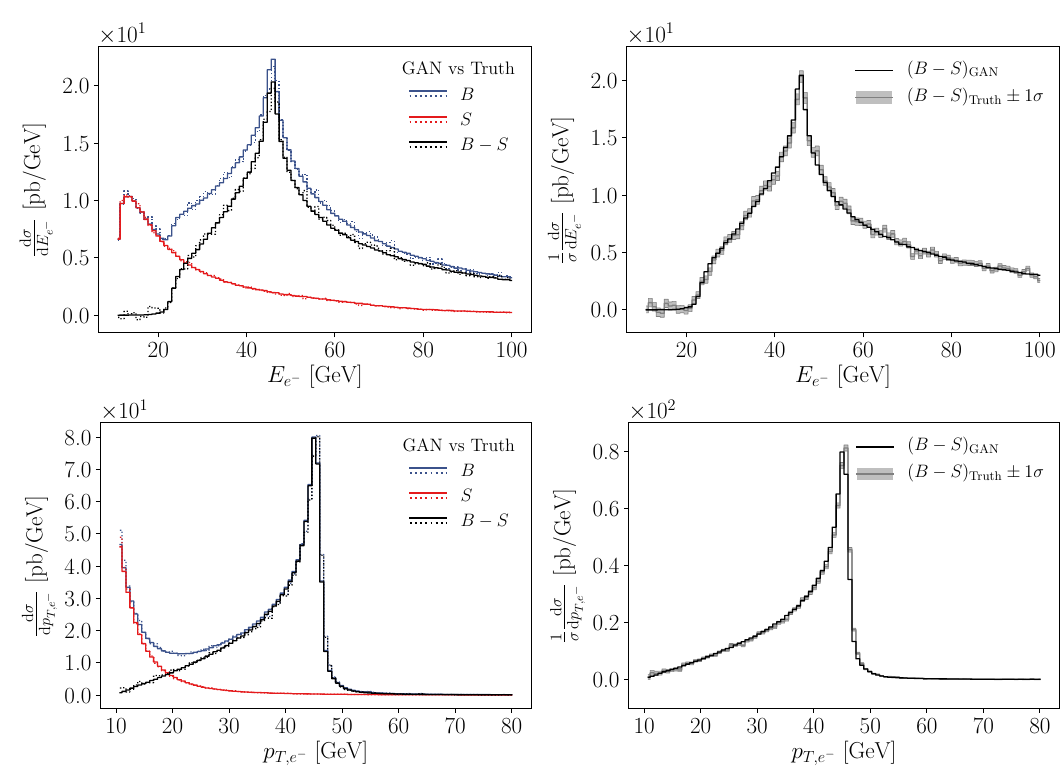
Figure 6: Left: Generated (solid) and true (dashed) e + e − events at the LHC for the two input distributions and the subtracted output. Right: distribution of the subtracted events, true and generated, including the error envelope propagated from the input